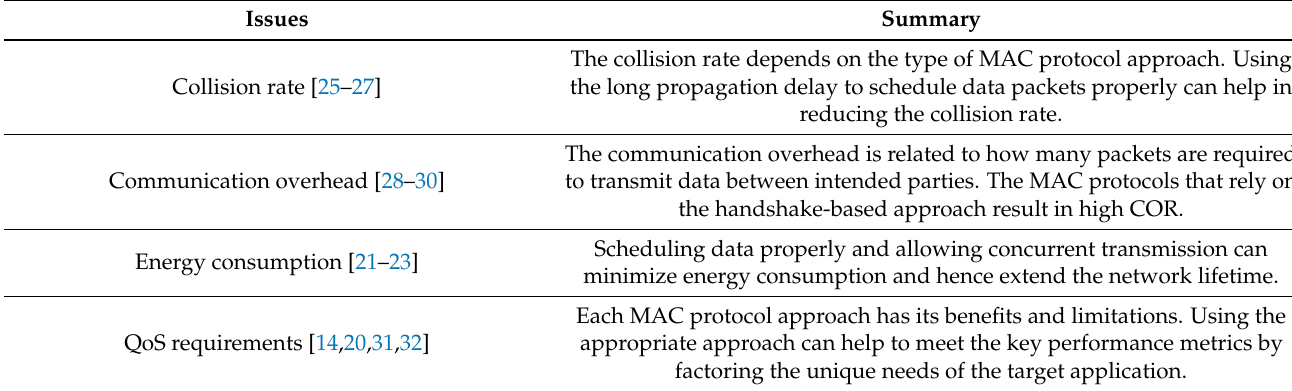
Table 1. Summary of UASN Issues and